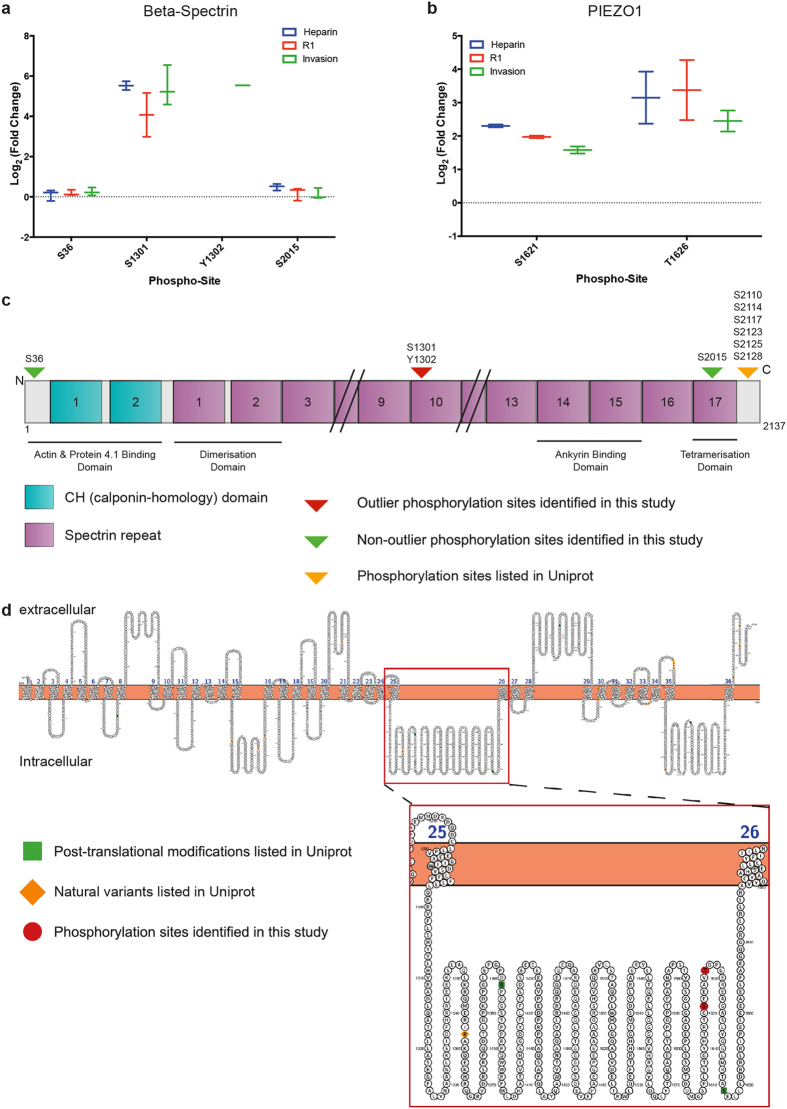
Phosphorylation of beta-spectrin and PIEZO1 in response to merozoites.Median centered individual phospho-peptide fold-change values pooled across the four invasion proteomic experiments for two proteins that contain a shortlisted outlier peptide, (a) beta-spectrin and (b) PIEZO1. Graphs display box and whisker plots showing the median, maximum and minimum values and inter-quartile range. Schematic representations of (c) beta-spectrin and (d) PIEZO1. Beta-spectrin phospho-sites identified through quantitative phospho-proteomics of invasion and their locations within the protein relative to key domains and regions of protein-protein interactions. Predicted membrane topology of PIEZO1based on Uniprot-derived consensus features from multiple prediction algorithms. Location of identified outlier phospho-sites is marked in red.